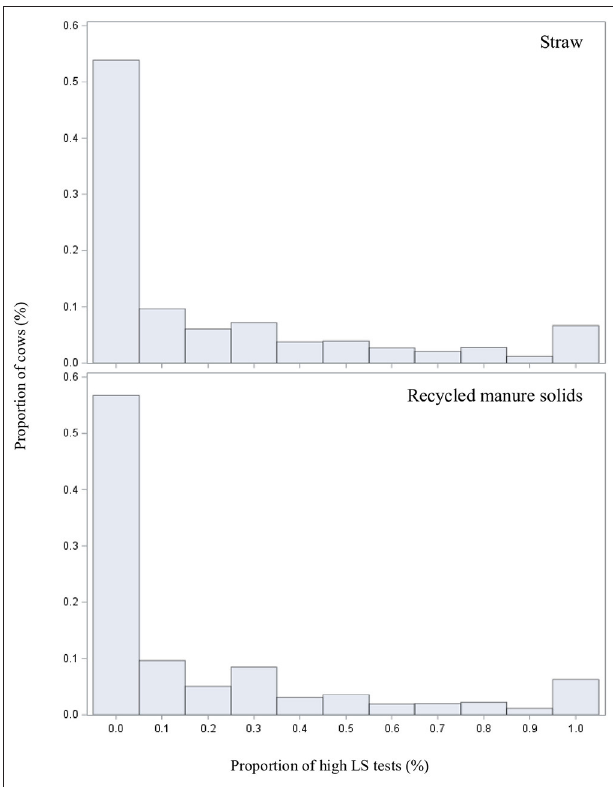
FIGURE 3 | Distributions of the cow’s proportion of milk tests with a linear score ≥ 4 by bedding type for 11,031 cows from 60 straw-bedded farms (top) and 20 recycled manure solids farms (bottom).